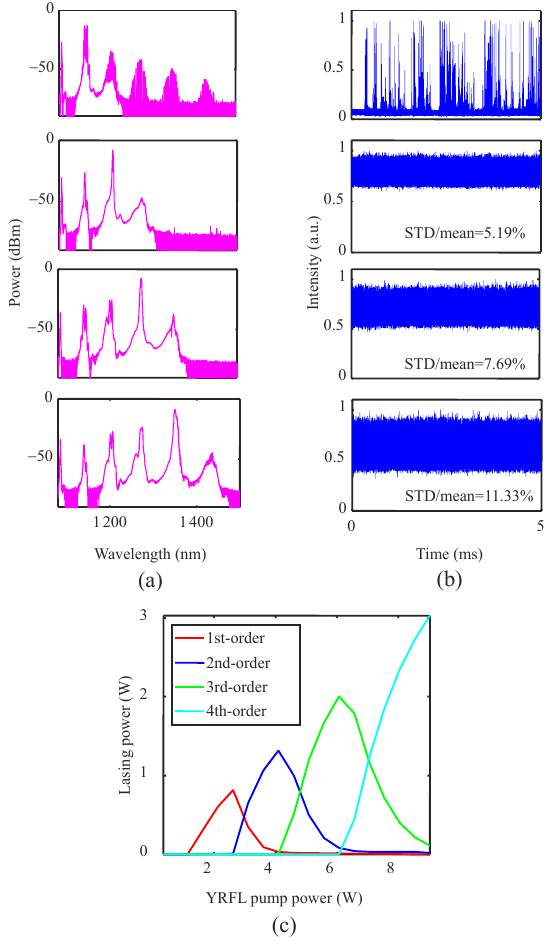
Fig. 5 Evolution of the CRRFL: (a) spectra, (b) time domain traces, and (c) lasing